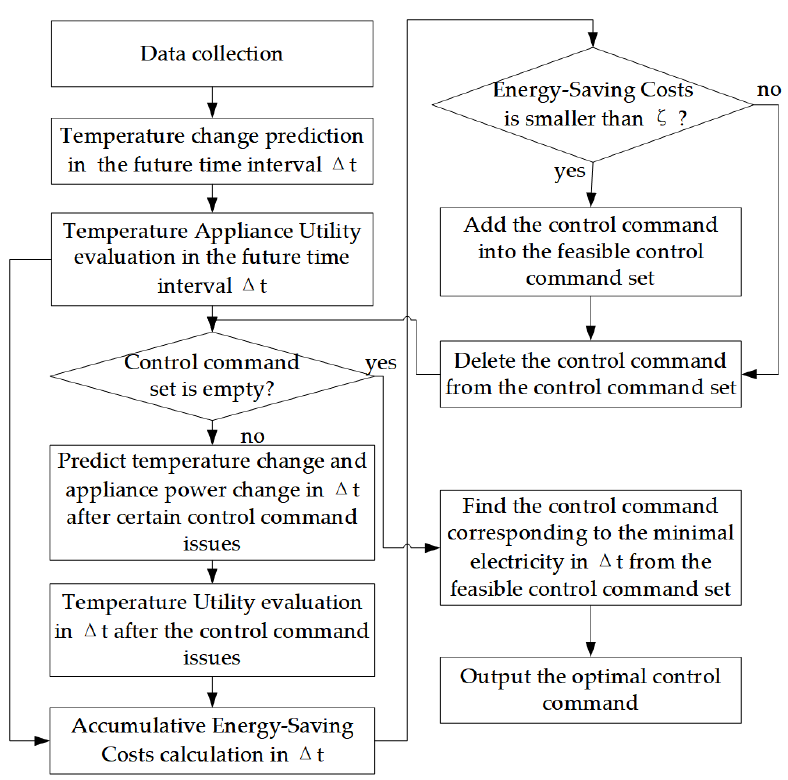
Figure 3. Energy saving optimization flow in the temperature dimension.